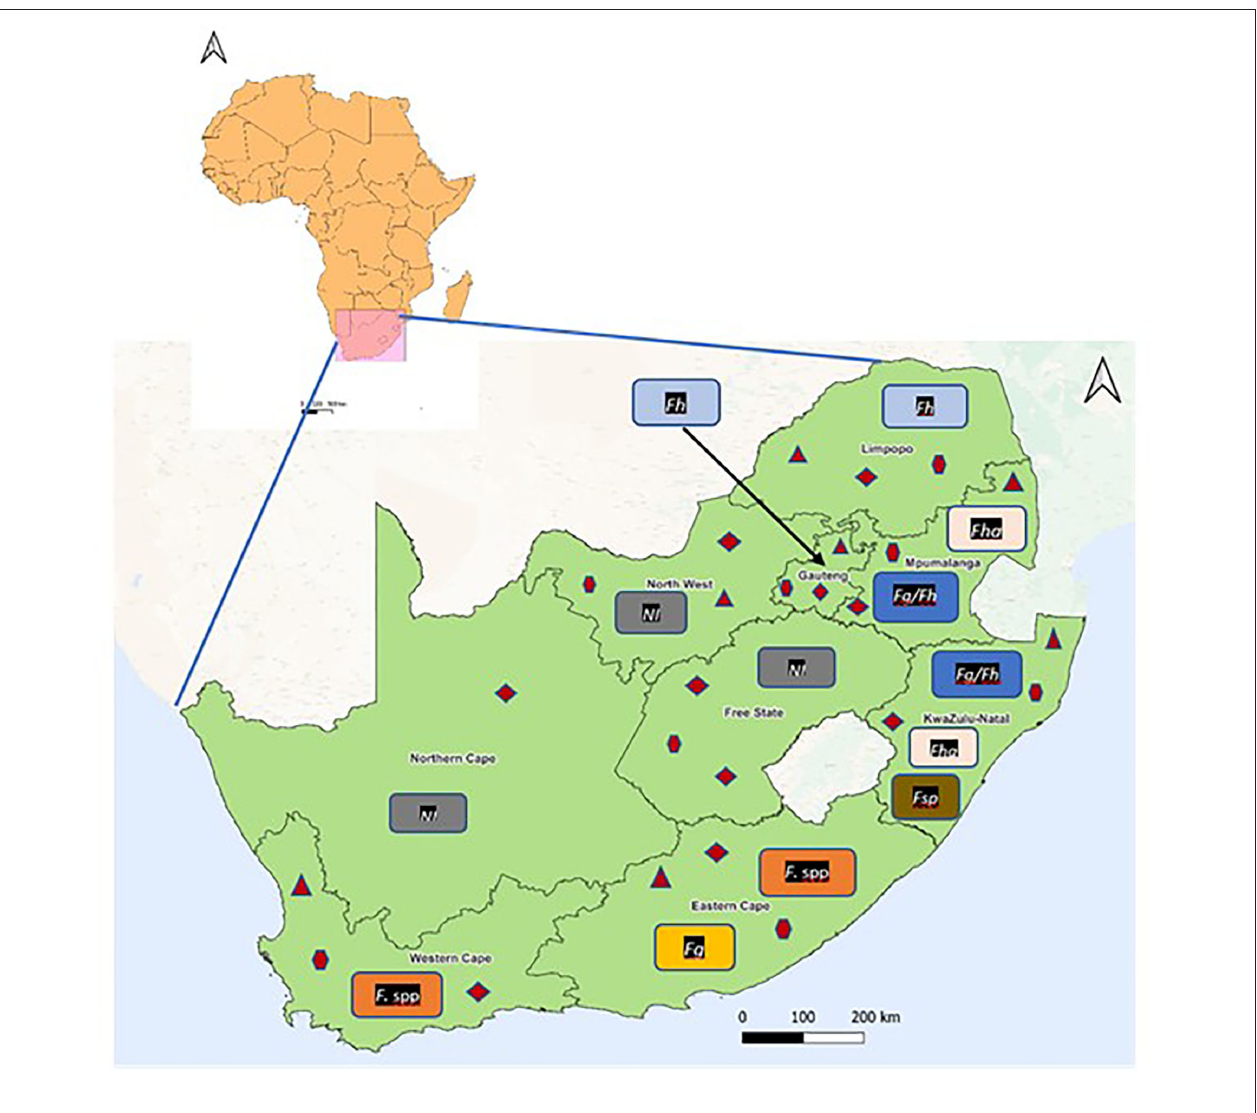
FIGURE 2 | Reported geographical occurrence of Fasciola species and their lymnaeid intermediate hosts in the provinces of South Africa. = Galba truncatula ; = Radix natalensis ; = Pseudosuccinea columella . Fg/Fh, Fasciola gigantica and F. hepatica ; Fg, F. gigantica ; Fh, F. hepatica ; Fha, Fasciola hepatica aspermic; Fasciola spp, Fasciola species; Fasciola sp, Suspected Fasciola hybrid; NI, No information available on Fasciola